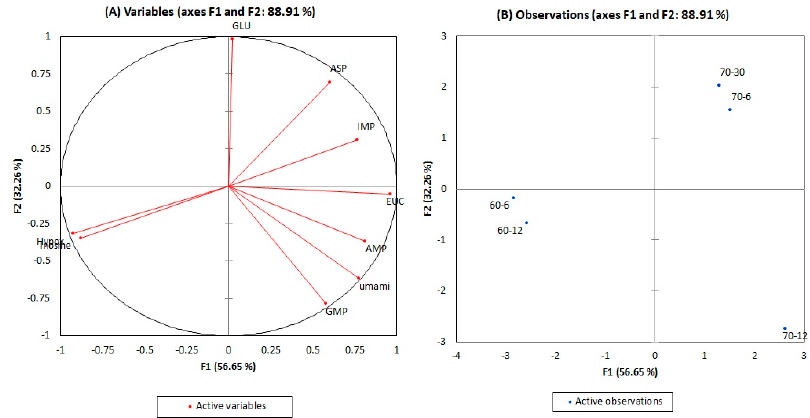
Figure 2. Principal component analysis of umami amino acids and 5’-nucleotides on umami sensory feature in cooked beef semitendinosus ( A : variables plot; B : observation plot). Abbreviation in the A graph: EUC: equivalent umami concentration; GLU: glutamic acid; ASP: aspartic acid; AMP: adenosine-5’-monophosphate; IMP: inosine-5’-monophosphate; GMP: guanosine-5’-monophosphate; hypox: hypoxanthine. In the B graph, the samples are identified as follows: 60-6 and 60-12: sous-vide cooked at 60 °C for 6 and 12 h; 70-6 and 70-12: sous-vide cooked at 70 °C for 6 and 12 h; 70-30: control, cooked at 70 °C for 30 min.